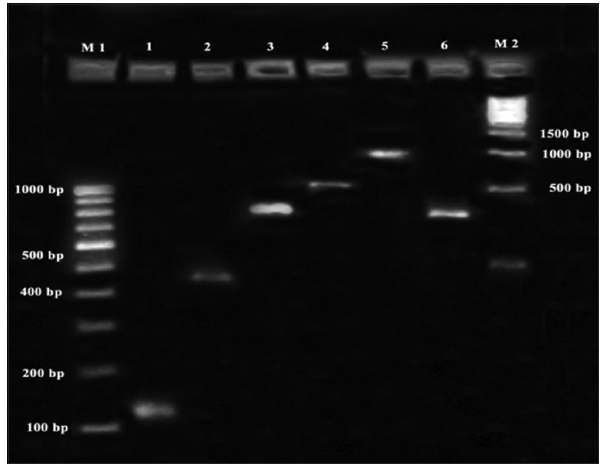
Figure-1: Polymerase chain reaction profile of Listeria monocytogenes isolate obtained with six